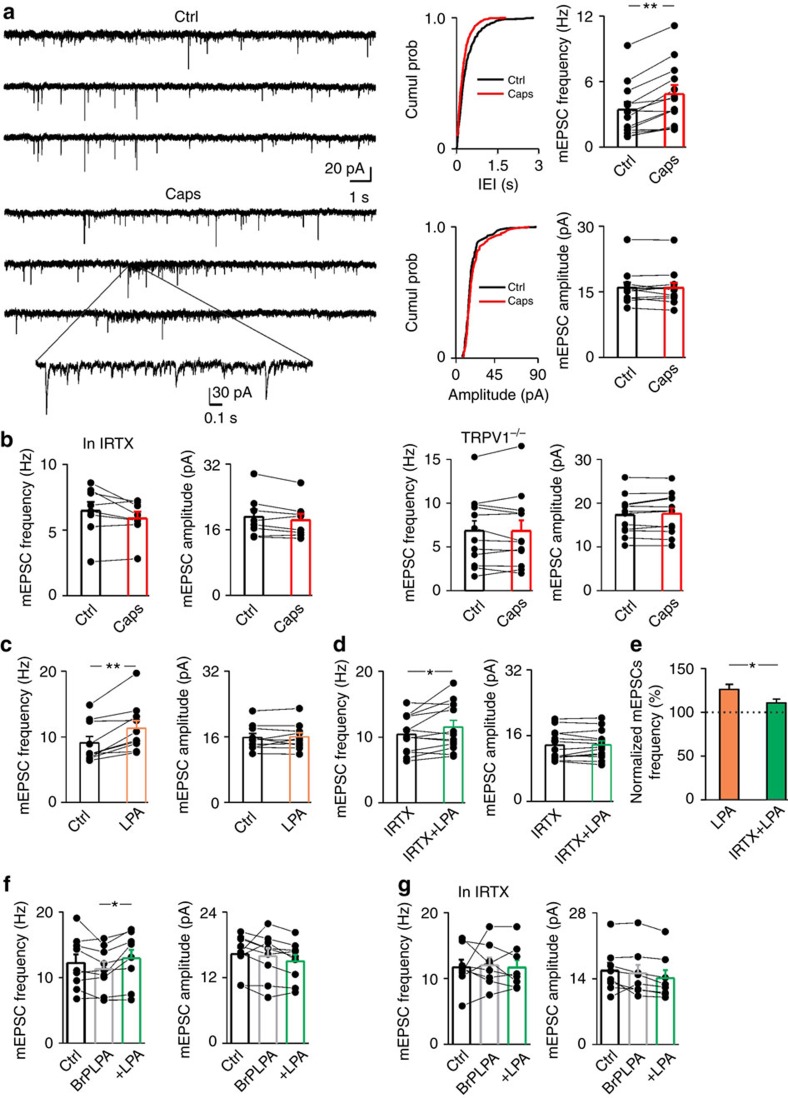
TRPV1 activation increases mEPSCs onto pyramidal neurons of the ACC.(a) Left, example traces of AMPAR mEPSCs recorded from a PN at −70 mV, in control and after 1 μM capsaicin (caps), in the presence of picrotoxin (100 μM). Below trace shows expanded trace recording during caps. Middle, cumulative distributions of mEPSC interevent interval (IEI) and amplitude from cell shown on the left (P<0.02 and P=0.32 respectively). Right, summary histograms and line series plots of mEPSC frequency and amplitude showing that capsaicin significantly increases the frequency but not the amplitude of mEPSCs (from 3.40±0.71 to 4.83±0.84 Hz, n=12, P<0.001; from 15.97±1.13 to 15.90±1.60 pA, n=12, P=0.83). Data are values from single cells (black filled circle) and mean±s.e.m. (b) Group data of mEPSC frequency and amplitude showing the lack of effect of capsaicin in the presence of the TRPV1 antagonist IRTX (left; from 6.46±0.68 to 5.88±0.50 Hz, n=8, P=0.11) or in cortical tissue from TRPV1−/− mice (right; 6.84±1.15 to 6.81±1.20 Hz, n=12, P=0.9). (c) Left, summary graph of mEPSC frequency and amplitude before (black bar; 9.10±0.96 Hz and 15.43±0.95 pA, n=10) and during 5 μM LPA (orange bar; 11.32±1.1 Hz and 15.38±1.07 pA, n=10). LPA significantly boost mEPSC frequency (P<0.002; Wilcoxon Signed Ranks Test). (d) Same as in previous graphs but in the presence of IRTX (IRTX 10.41±0.76.14, IRTX+LPA 11.54±1 Hz, n=13; P<0.05 Paired Sample T Test; IRTX 12.92±0.93,IRTX+LPA 13.01±0.93 pA, n=13). (e) Note that LPA is significantly less effective when TRPV1 is inhibited (P<0.05, Two-sample T test) (*P<0.05, **P<0.001). (f,g) In the presence of LPA1-4 metabotropic receptors antagonist BrP-LPA, LPA increases glutamatergic transmission by TRPV1 activation. (f) Left, summary graphs of mEPSC frequency and amplitude before (black bar; 12.21±1.32 Hz and 16.31±1.9 pA, n=9), during BrP-LPA (5 μM; grey bar; 11.32±1.1 Hz and 15.95±1.4 pA, n=9) and with LPA (green bar; 12.94±1.3 Hz and 15.00±1.2 pA, n=9). (g), same as in f but with the addition of IRTX (ctrl 11.71±1.14 Hz, BrLPA 12.03±1.15 Hz, BrLPA+LPA 11.67±1.16 Hz, n=8; ctrl 15.70±1.70 pA, BrLPA 15.16±1.80 pA, BrLPA+LPA 14.31±1.60 pA, n=8). (*P<0.05, Paired Sample t-Test).